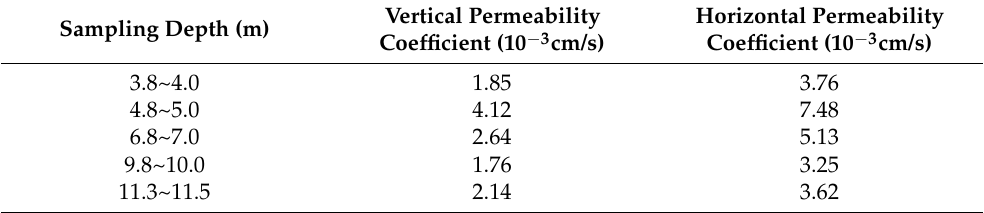
Table 2. Permeability coefficients of the silt. Sampling Depth